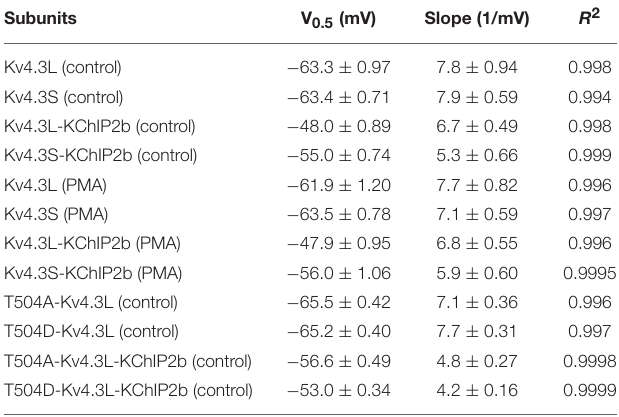
TABLE 1 | Steady-state inactivation parameters.